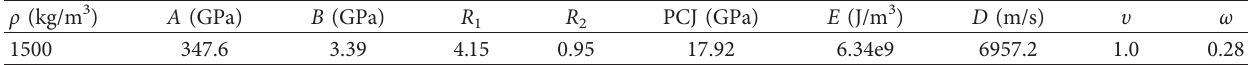
Table 3: Explosive material parameters [36].